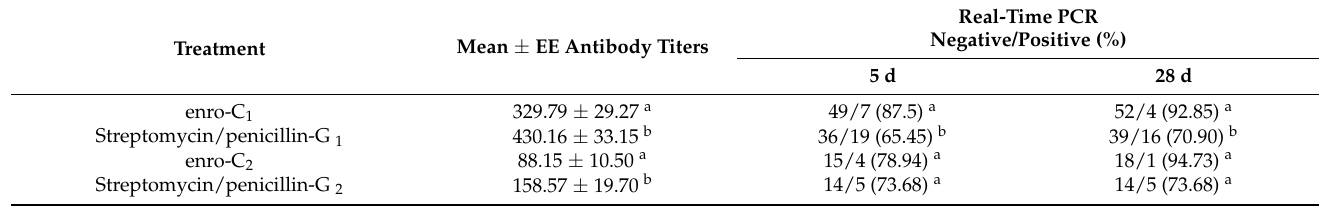
Table 4. Antibody titers by the microscopic agglutination test (MAT) and polymerase chain reac- tion (PCR) of urine samples in cows affected by Leptospira spp. after treatment with enrofloxacin hydrochloride-dihydrate (enro-C) or streptomycin plus procaine penicillin-G in the highlands (1) and a tropical area in Mexico (2).